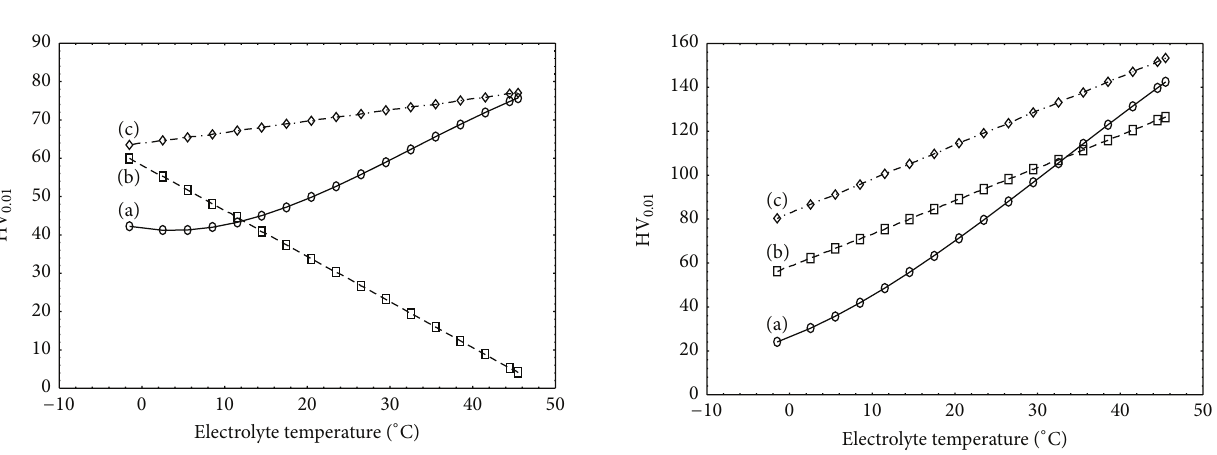
Figure 12: The dependence of the layer microhardness on the tem- perature of the electrolyte: c (H 2 SO 4 ) = 1.99 mol ⋅ L −1 , c (C 2 H 2 O 4 ) = 0.06 mol ⋅ L −1 , U = 13.5 V, t = 20 min. (a) 1A ⋅ dm −2 , (b) 3A ⋅ dm −2 , and (c) 5 A ⋅ dm −2